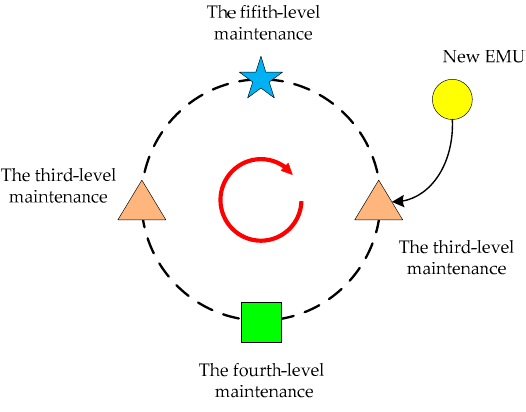
Figure 2. The HM cyclic graph.